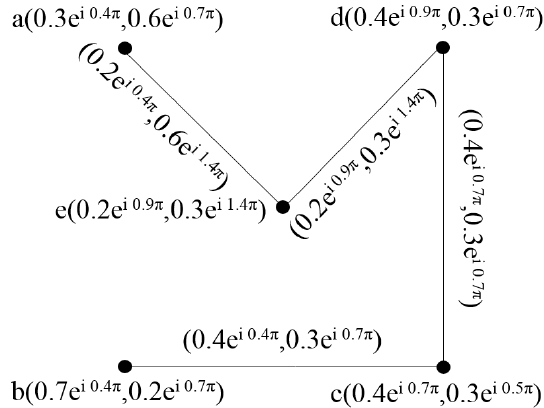
Figure 13. Complex intuitionistic fuzzy graph of G